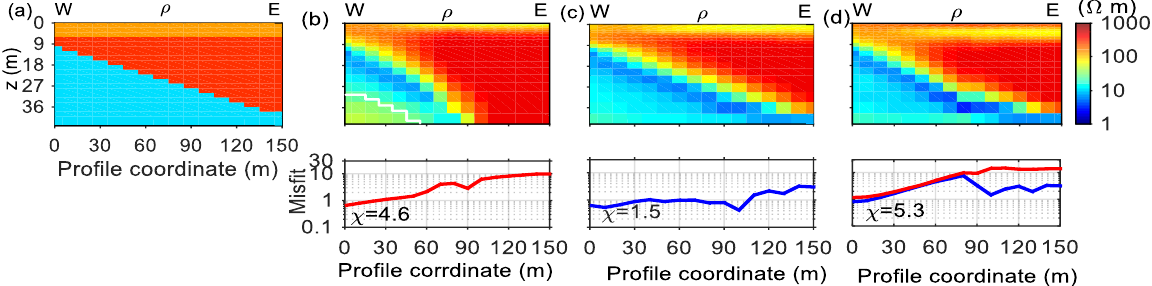
Figure 10. Comparison between the true resistivity value ( a ) and resistivity-inversion results of the IP responses of the moderate chargeable medium: by x -data only ( b ); z -data only ( c ); and x and z data ( d ). The meanings of the curves and the area are the same as in Figure 7.